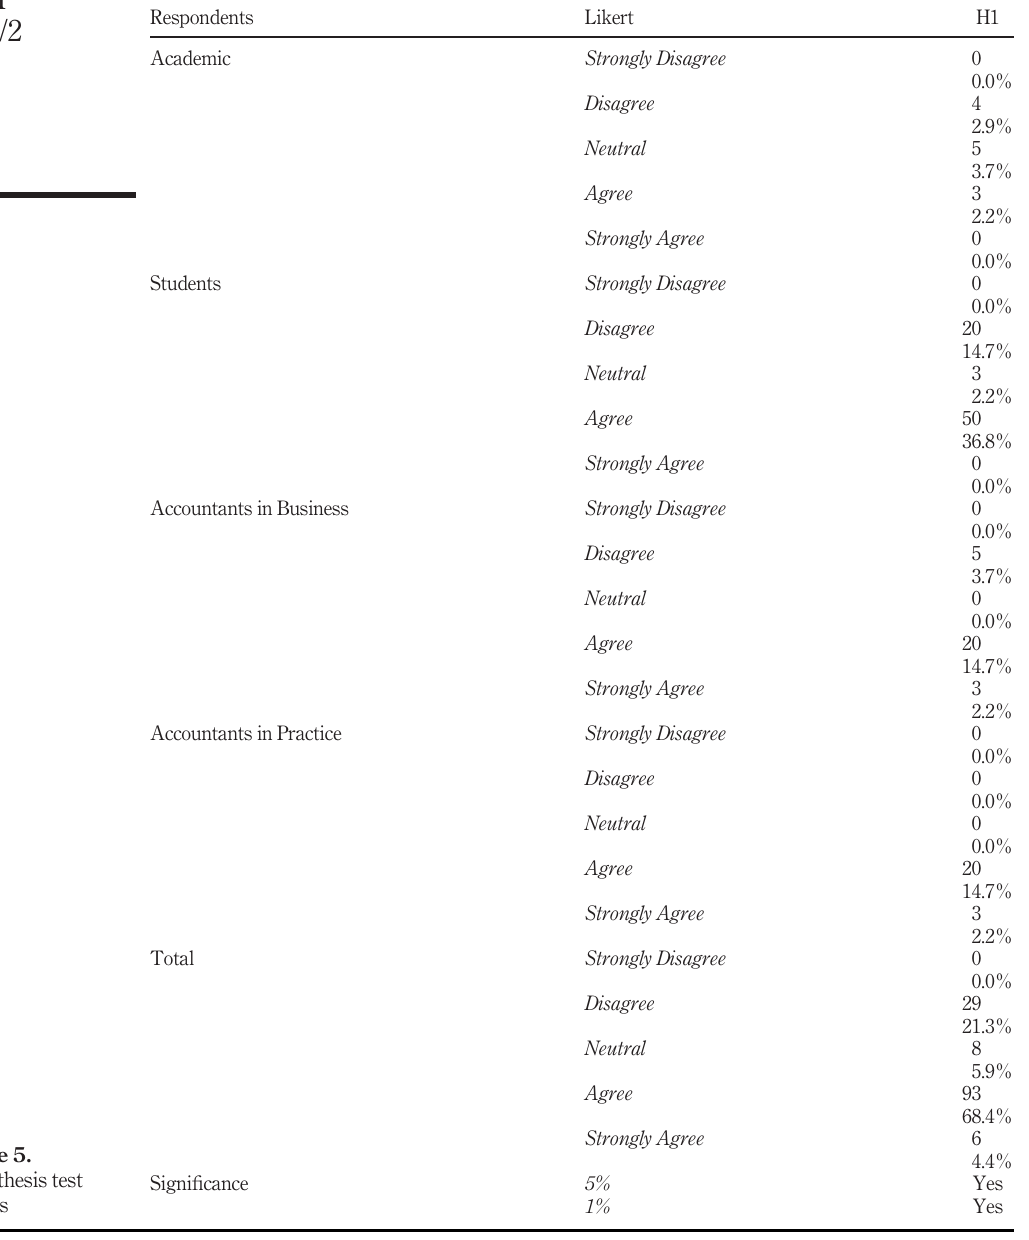
Table 5. Hypothesis test